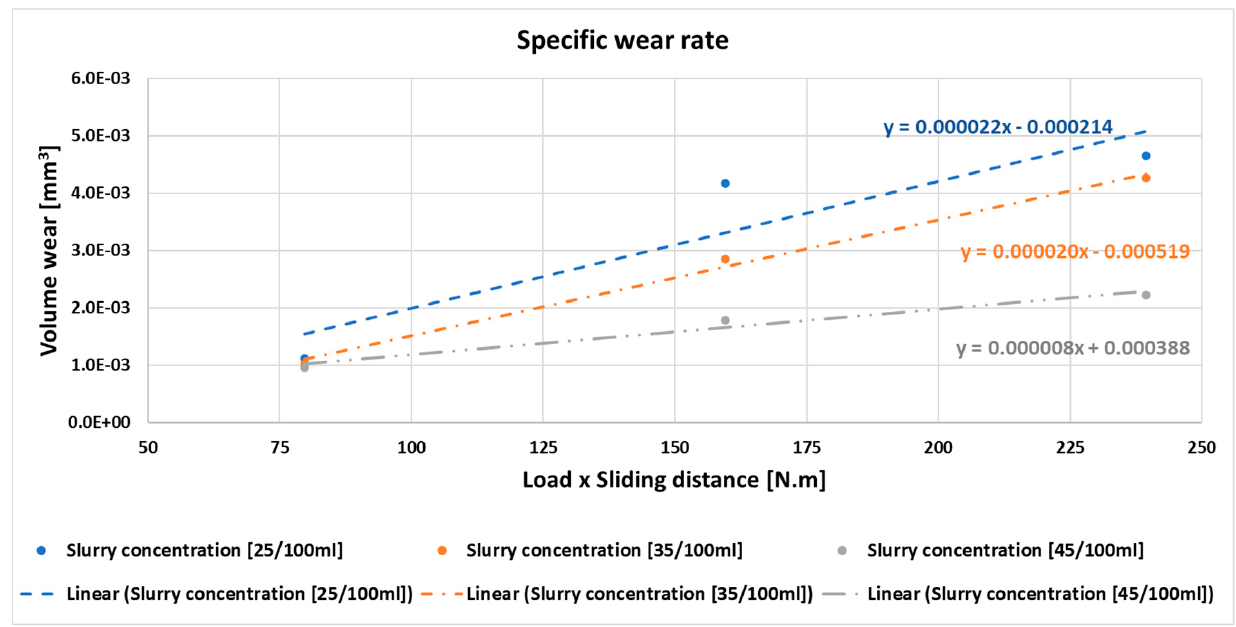
Figure 11. Specific wear rate regarding abrasive particles concentration for different number of cycles and 2 N normal load.